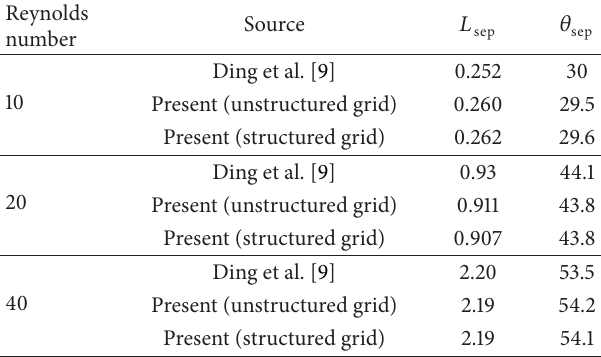
Table 1: Comparison of value of the recirculation length and separation angle for Re = 10, 20, and